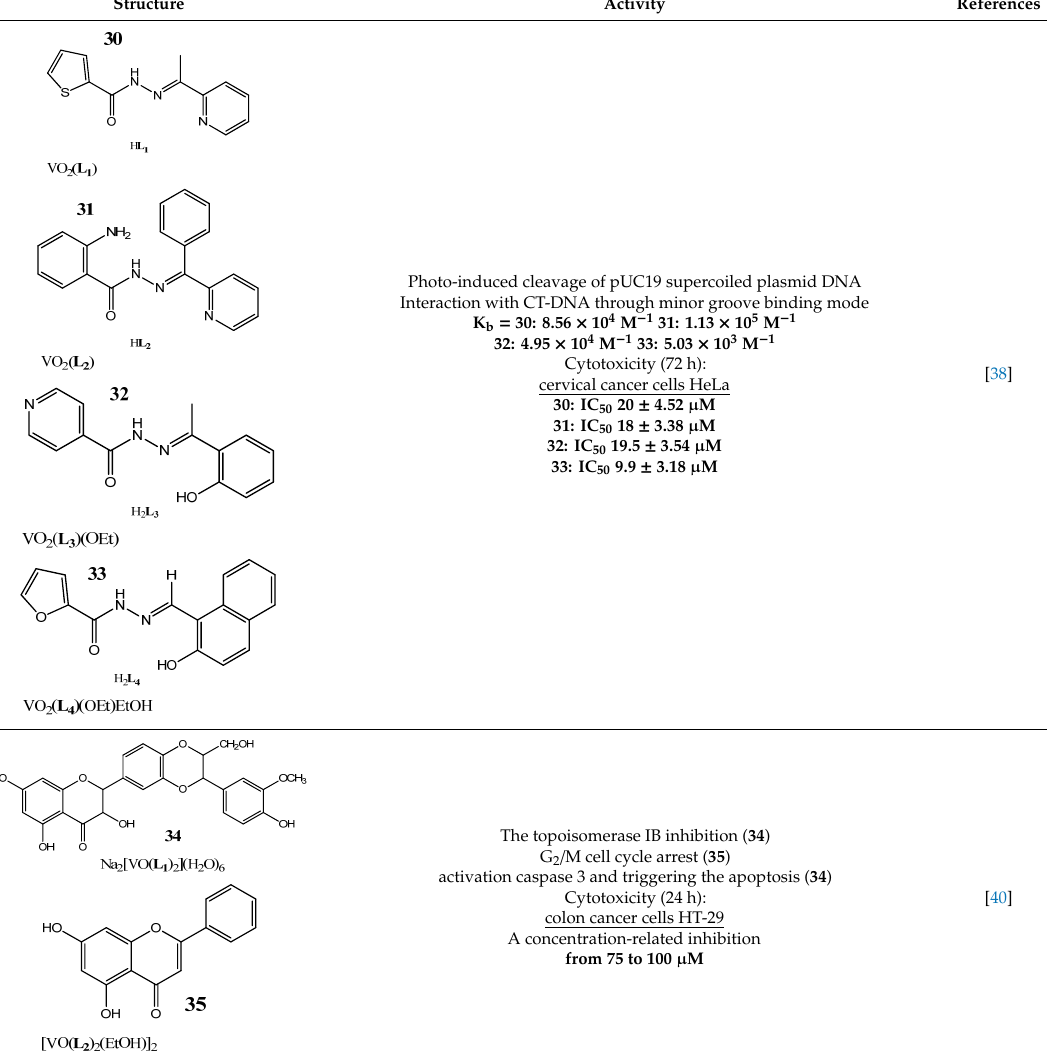
Photo-induced cleavage of pUC19 supercoiled plasmid DNA Interaction with CT-DNA through minor groove binding